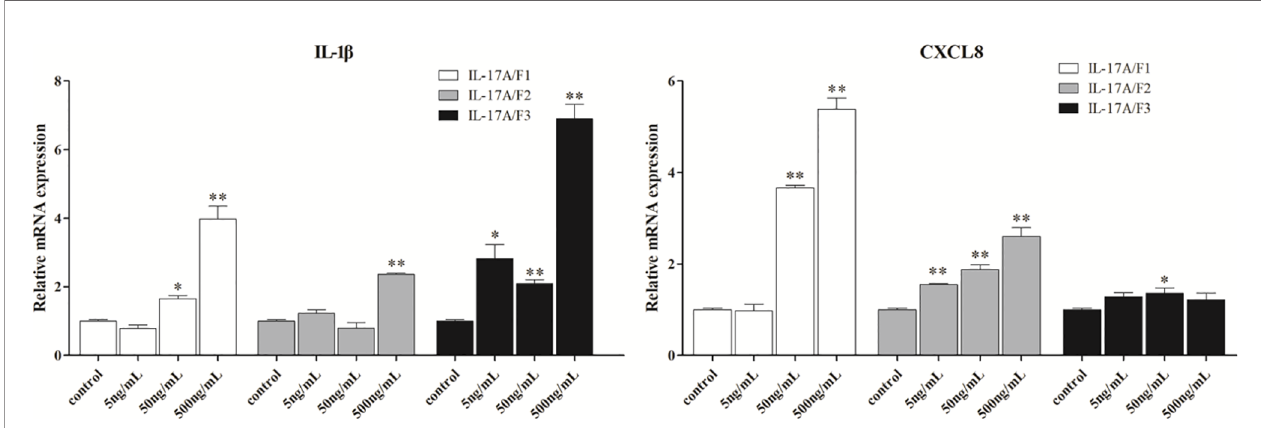
FIGURE 7 | Effects of recombinant Pf _IL-17A/F1, 2 and 3 dose course on the expressions of IL-1 b and CXCL8 mRNAs in PBLs of yellow cat fi sh. PBLs were treated with different doses of r Pf _IL-17A/F1, 2 and 3 proteins (5, 50, 500 ng/mL) for 6 h. Transcriptional fold changes of the IL-1 b and CXCL8 genes at different treatment doses were calculated compared to the control group. The PBLs were isolated from four individuals of yellow cat fi sh and were mixed equally, and the pooled sample was further divided into 12 experiment units for different experimental treatments. Columns and deviation bars represent the means and standard errors for each treatment ( n = 3), respectively. Signi fi cant difference at different treatment doses compared to the control is indicated by asterisks (* P < 0.05, ** P <